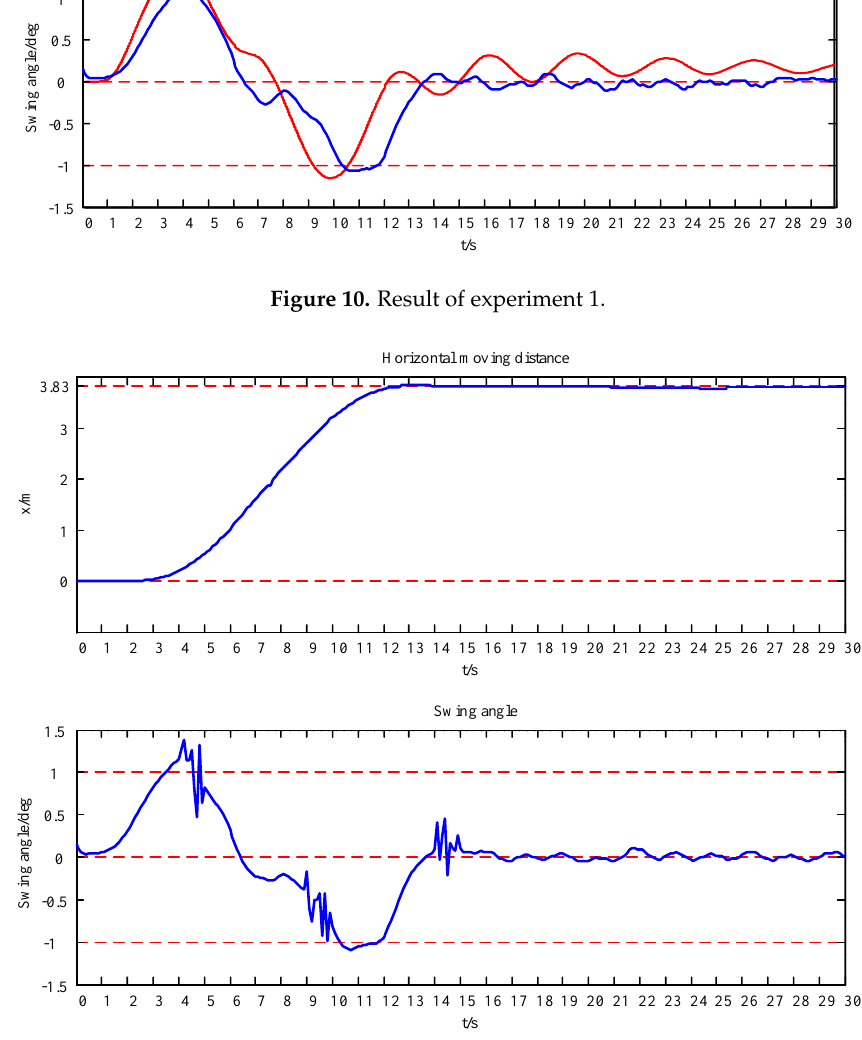
Figure 11. Result of experiment 2.